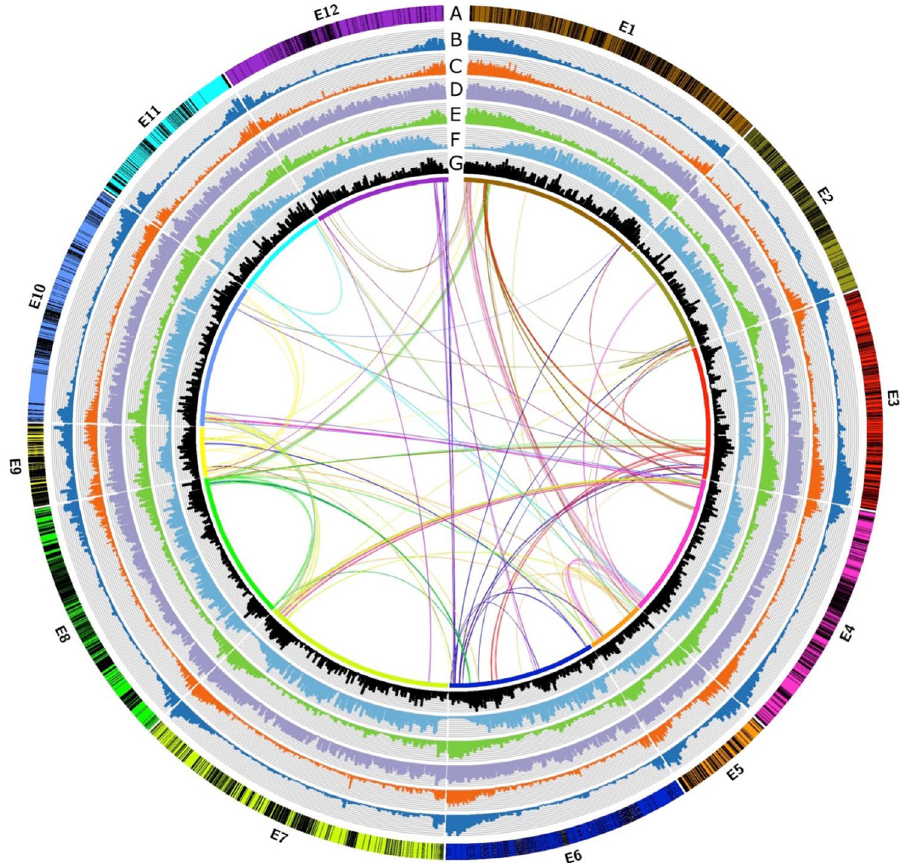
Figure 1. Topography of the eggplant genome. Track ( A ) Eggplant chromosomes with the genetic map (black bars represent the position of genetic markers used for anchoring scaffolds to pseudomolecules; Track ( B ) gene density; Track ( C ) RNA-seq expression data density; Track ( D ) overall repeat density; Track ( E ) DNA transposon density; Track ( F ) LTR-Gypsy transposon density; Track ( G ) LTR-Copia transposon density; Track ( H ) Intragenome syntenic regions originated from paleopolyploid events (for the parameters used to define syntenic thresholds, see Supplementary Information 2.7). Densities for tracks ( B , D , E , F , G ) are presented in 1-Mb intervals; for track ( C ) in 100-Kb